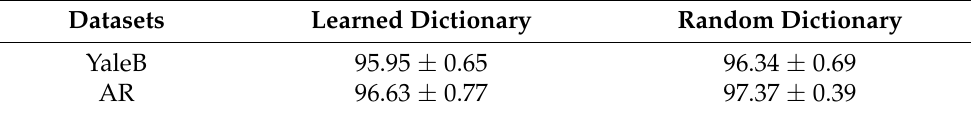
Table 5. Comparison of final recognition performance with or without dictionary learning in HIHT al-